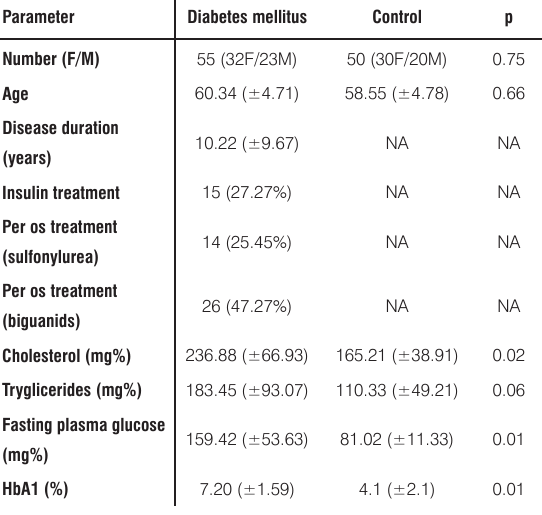
Table 1. Demographic characteristics of the study